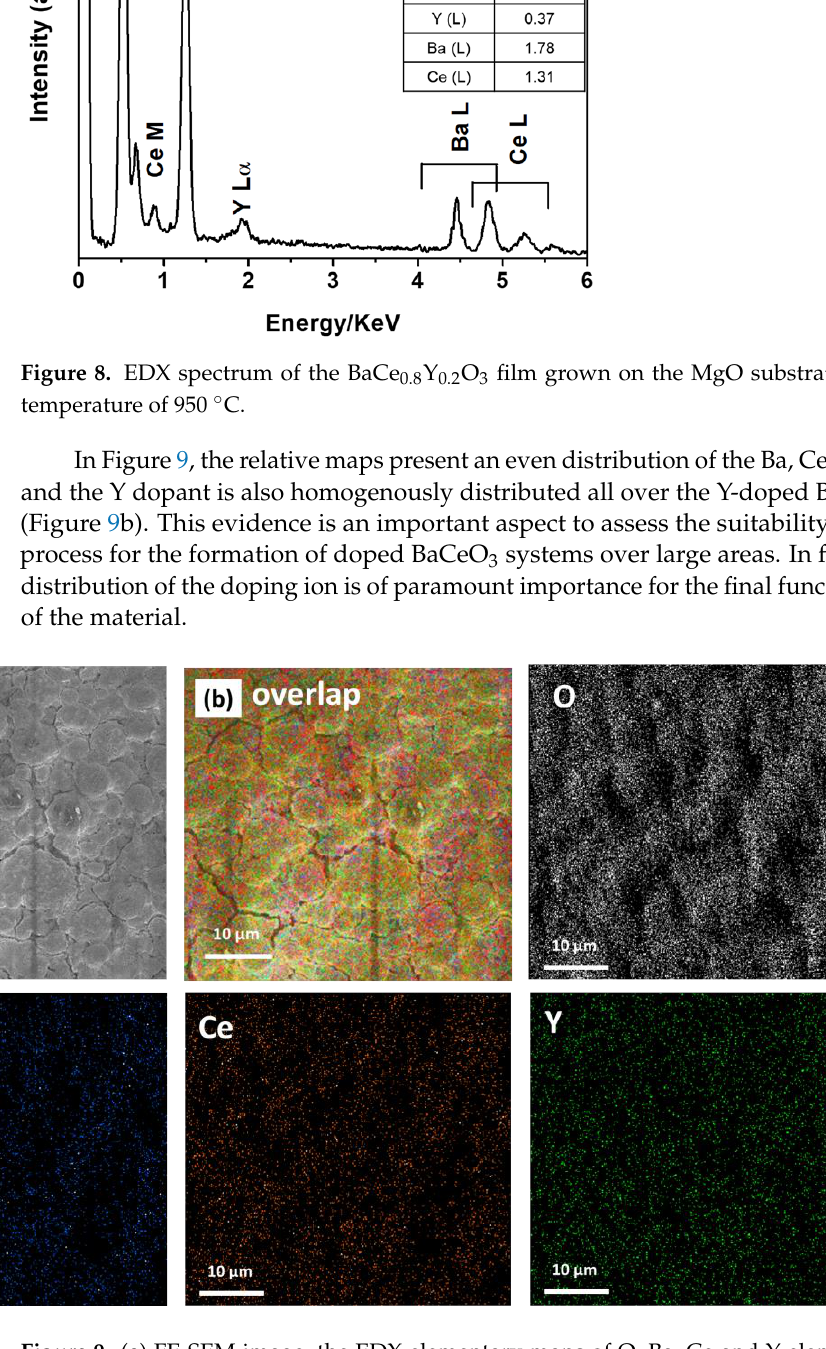
Figure 9. ( a ) FE-SEM image, the EDX elementary maps of O, Ba, Ce and Y elements, and ( b ) the overlapped map image of the BaCe 0.8 Y 0.2 O 3 film grown on the MgO substrate at a deposition temperature of 950 °C.